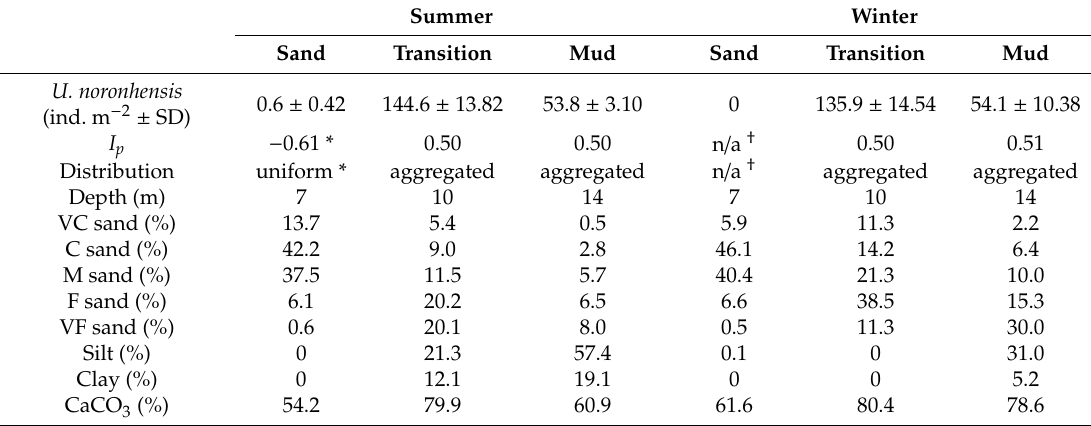
Table A1. Upogebia noronhensis (n = 9) mean density (ind. m − 2 ± SE), Standardized Morisita Index ( I p ) (n = 18) and sediment parameters in the three sample zones during the summer and winter periods. Sand classes: VF sand = very fine sand; F sand = fine sand; M sand = medium sand; C sand = coarse sand; VC sand = very coarse sand.